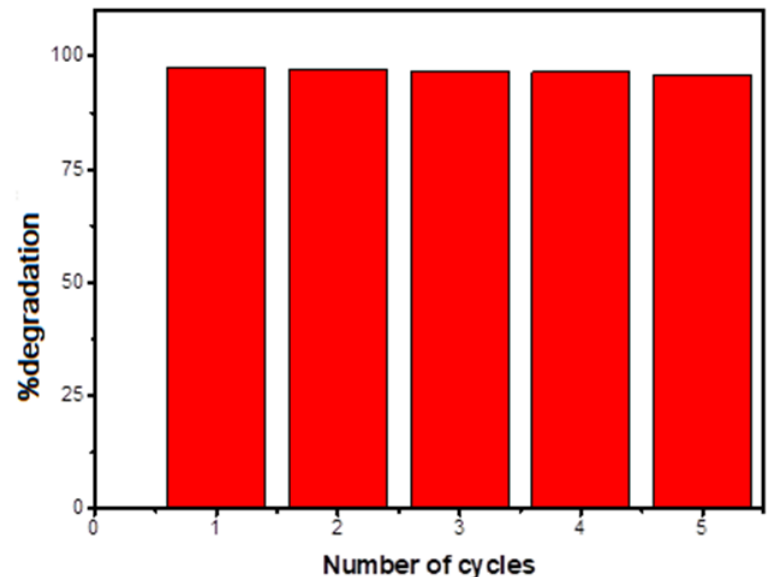
Figure 17. Recycling of catalyst for five experimental runs.